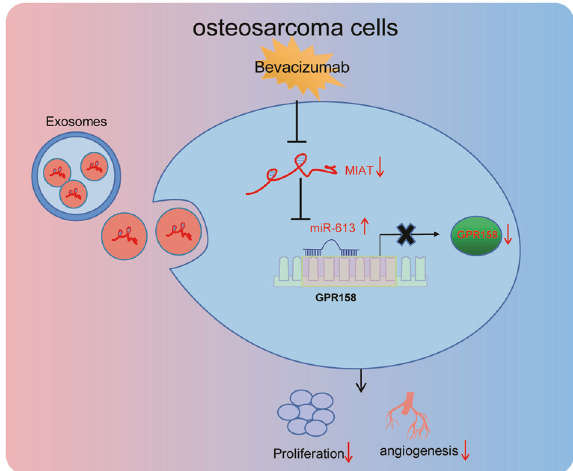
Fig. 7 Schematic diagram of the mechanism by which Bev affects osteosarcoma cell proliferation and angiogenesis. Serum-EVs deliver MIAT to osteosarcoma cells. Bev can inhibit the expression of MIAT in osteosarcoma cells and upregulate the expression of miR- 613. miR-613 targets GPR158 and inhibits its mRNA and protein expression, thereby inhibiting the proliferation and angiogenesis of osteosarcoma